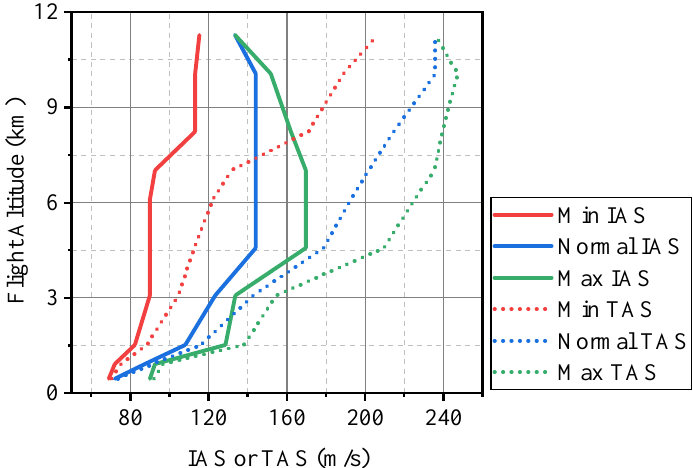
Figure 5. Indicated airspeed (IAS) and true airspeed (TAS) for aircraft A320 in the international standard atmosphere (ISA)